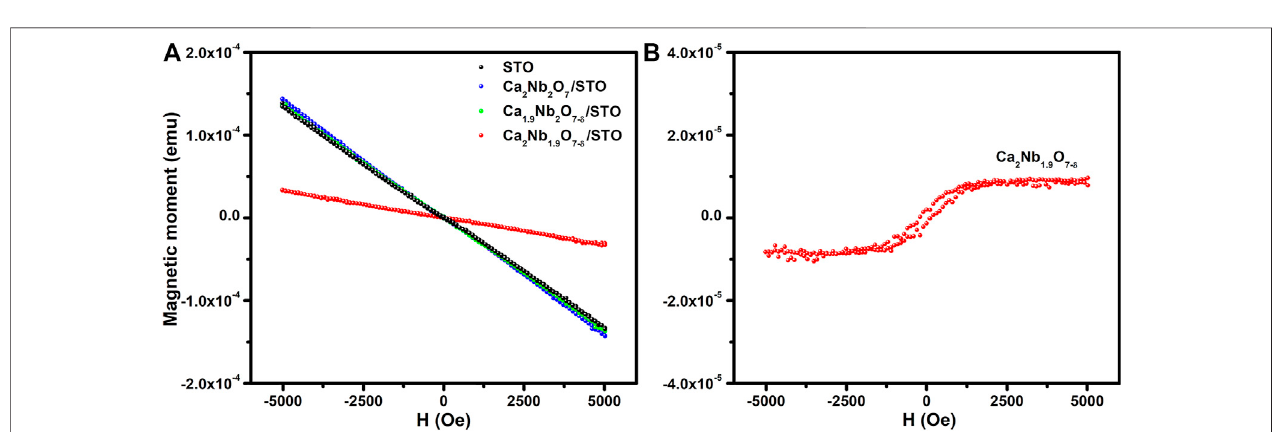
FIGURE 3 | Original MH curves for the STO substrate, Ca 2 Nb 2 O 7 , Ca 1.9 Nb 2 O 7- δ and Ca 2 Nb 1.9 O 7- δ fi lms on STO measured at room temperature (A) , and the MH curve for the